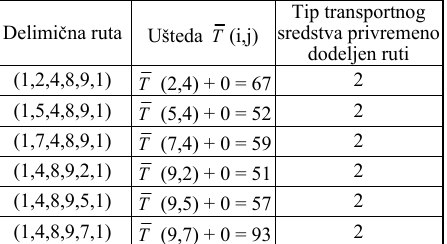
U{tede i tipovi transportnih sredstava